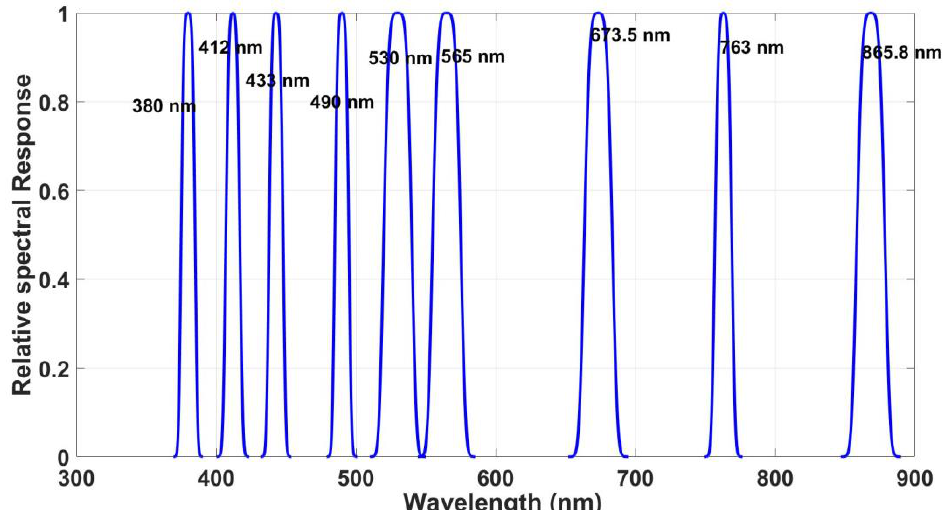
Figure 1. The relative spectral response of the global change observation mission-climate (GCOM-C) visible and near-infrared (VNIR) channels. The spectral response data were obtained from the GCOM-C official portal (https://suzaku.eorc.jaxa.jp/GCOM_C/instruments/files/sgli_rsr_f_for_algorithm_201008.txt). The effectiveness of polarization and UV wavelengths for aerosol data retrieval was